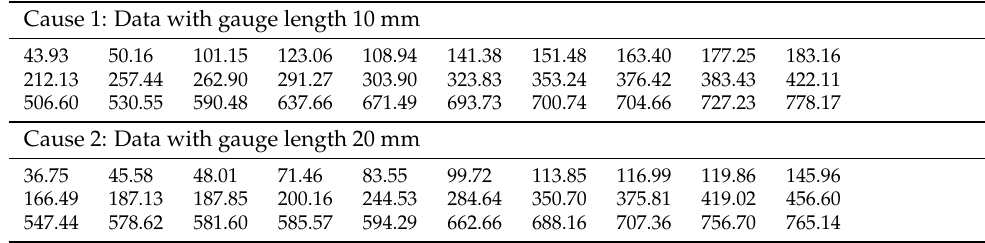
Table 4. Breaking strengths of jute fiber under different gauge length from Xia et al. (2009). Cause 1: Data with gauge length 10 mm